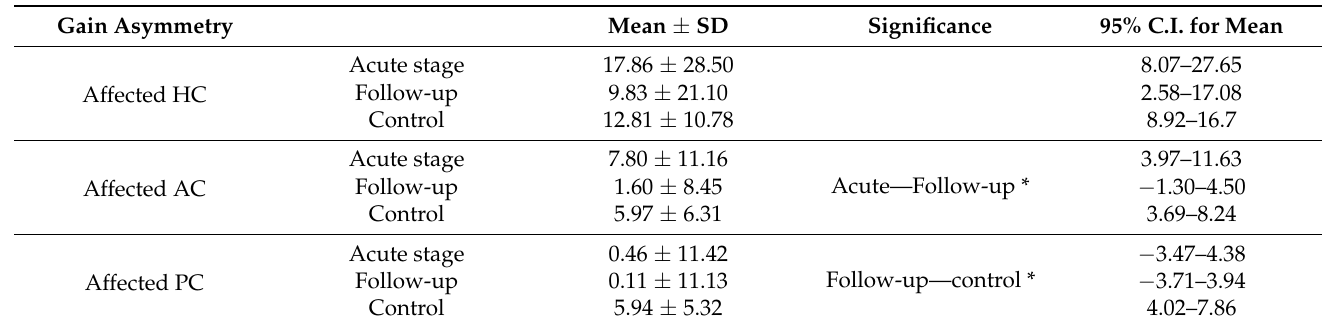
Table 2. Gain asymmetry values of vHIT in vestibular neuritis at the acute stage and follow-up in the